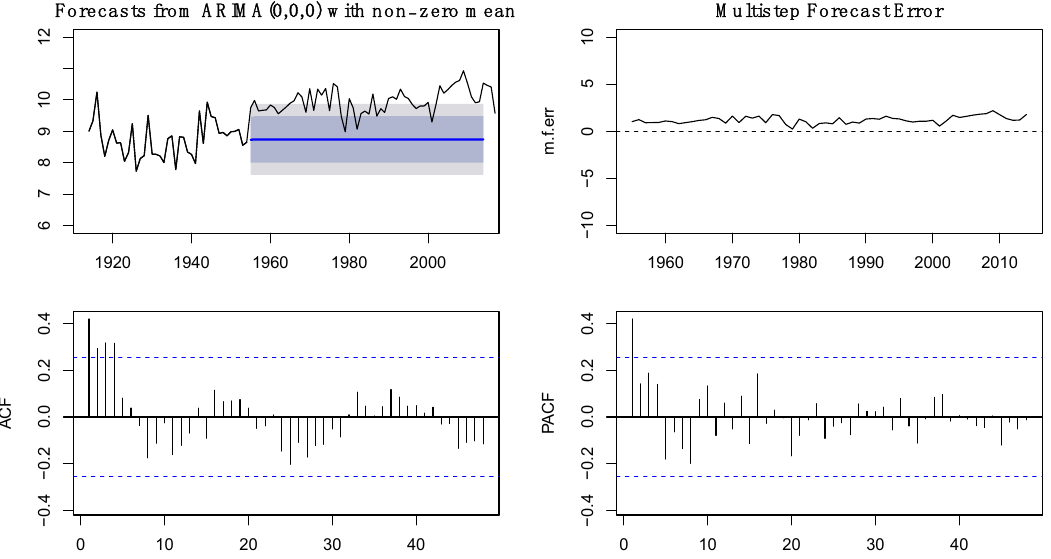
Figure 4. Forecast of captures without dam construction using the ARIMA models based on pre-intervention capture data for Petromyzon marinus . Model accuracy was evaluated through its multistep error, ACF, and PACF. Forecasts are shown by the blue line and shaded grey areas.